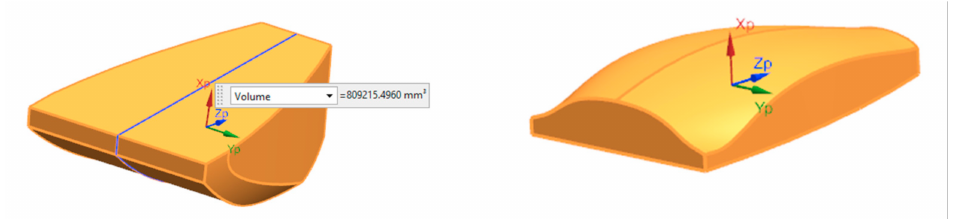
internal section view, ( b ) section view and designated areas. 4